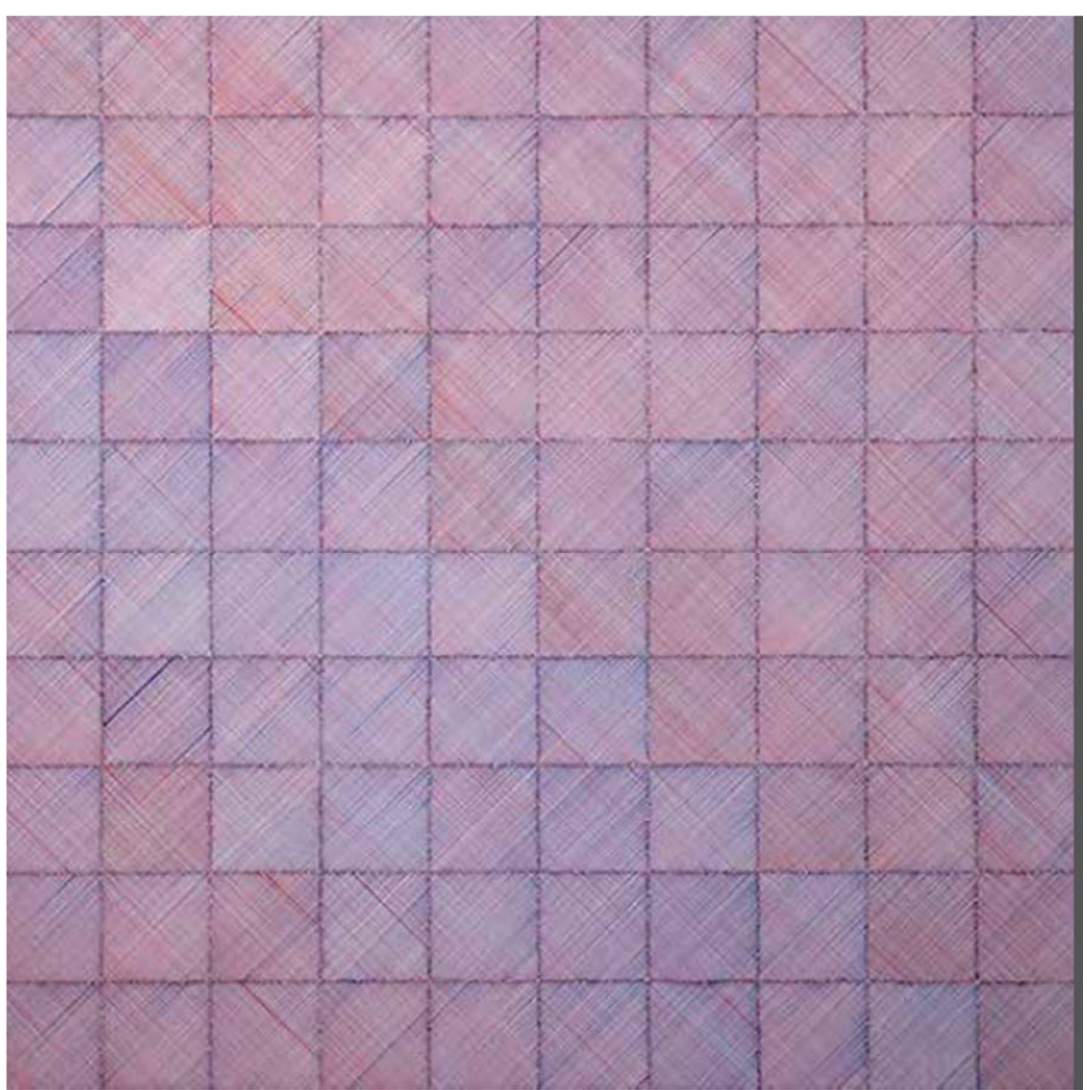
Figure 2. Ernest Edmonds, Drawing: 7 (1975).